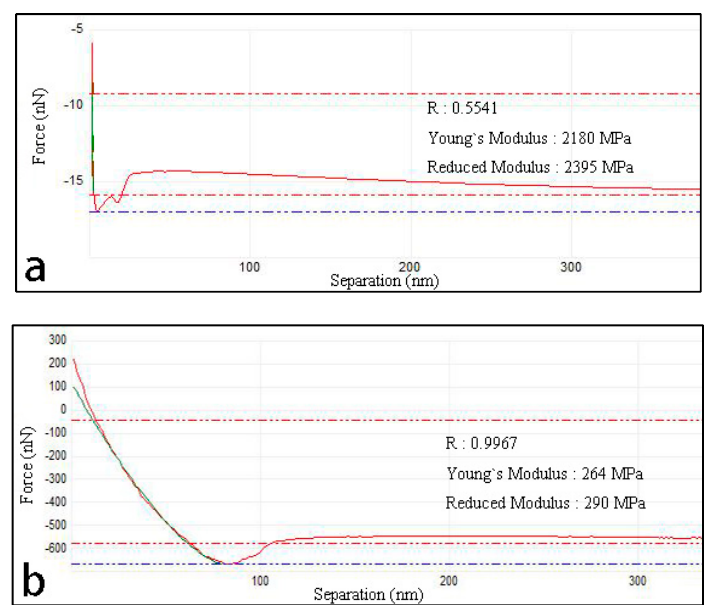
Figure 17. Mechanical properties analysis of GNPs ( a ) and GOs-SH ( b ) by AFM.